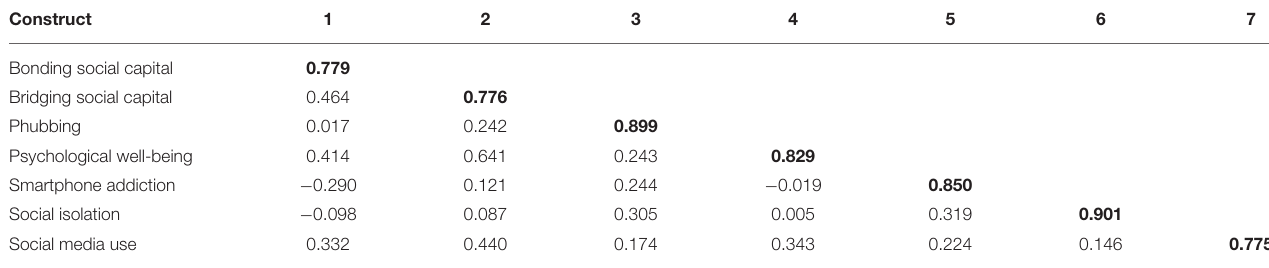
TABLE 4 | Discriminant validity and correlation.